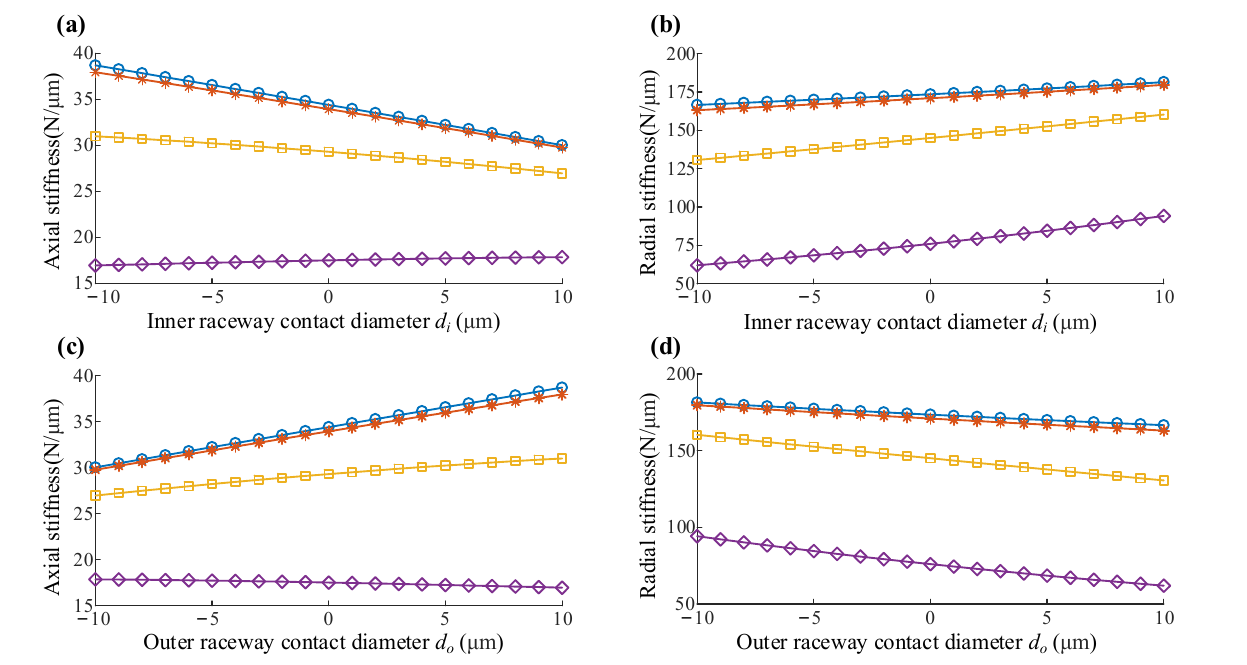
Figure 14. The influences of the contact diameter of inner or outer raceway on bearing stiffness: ( a ) bearing axial stiffness varies with the contact diameter of inner raceway d i ; ( b ) bearing radial stiffness varies with the contact diameter of inner raceway d i ; ( c ) bearing axial stiffness varies with the contact diameter of outer raceway d o ; ( d ) bearing radial stiffness varies with the contact diameter of outer raceway d o ; ( — ○ — rotating speed = 0 rpm, — — rotating speed = 5000 rpm, — □ — rotating speed =10,000 rpm, — ◇ — rotating speed = 20,000 rpm).